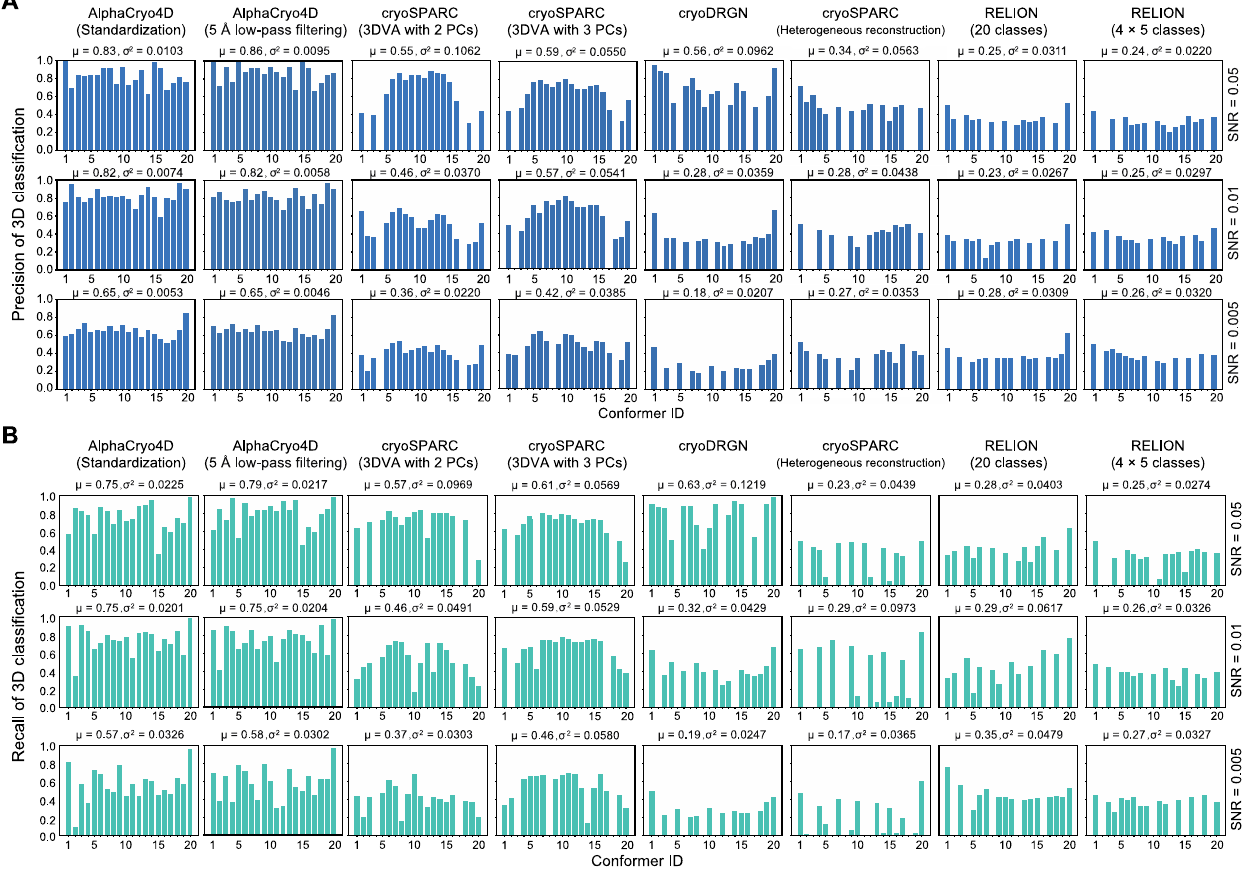
Figure 3. Performance comparison of AlphaCryo4D with alternative 3D classification methods using the simulated heterogeneous NLRP3 datasets of different SNRs. ( A ) 3D classification precision of the simulated datasets by AlphaCryo4D (first column), AlphaCryo4D preprocessed by 5 Å low-pass filtering instead of standardization (second column), 3DVA with two and three principal compo- nents (PCs) in cryoSPARC (third and fourth columns), cryoDRGN (fifth column), heterogeneous reconstruction in cryoSPARC (sixth column) and maximum-likelihood 3D classification in